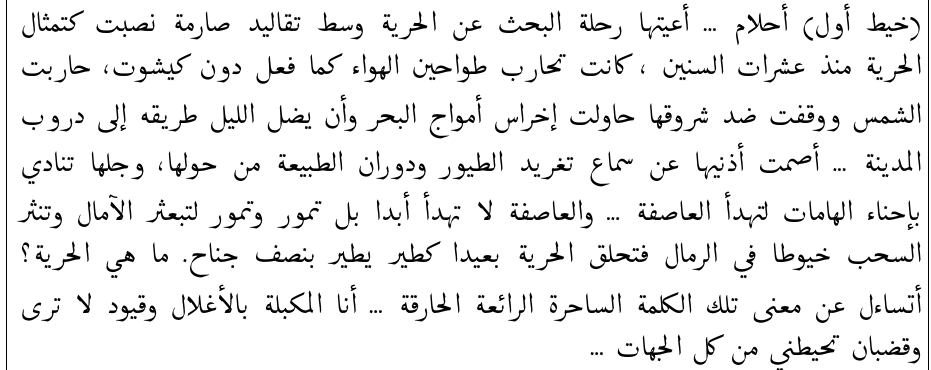
Figure 2. Sample view of the output of the automatic cleaning generated by Almoshatheb Alarabi tool and its